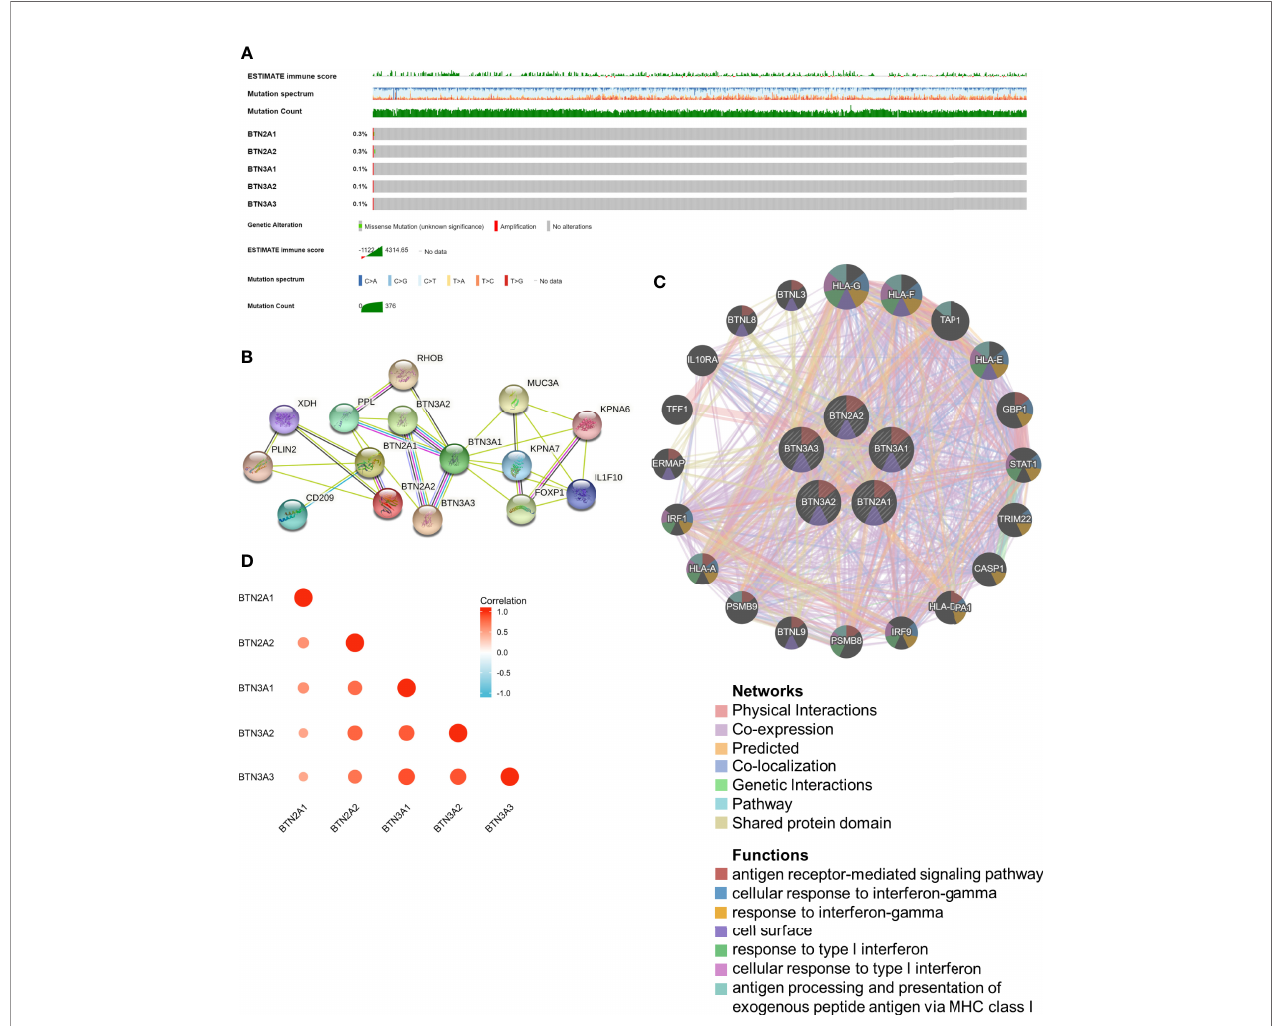
FIGURE 2 | Genomic alterations of BTN2/3 subfamily members and gene – gene and protein – protein interaction networks of genes of the TBC1D3 family. (A) The OncoPrint schematic provides an overview of genomic alterations of the BTN2/3 subfamilies in TCGA-GBMLGG merge cohort. (B) A network diagram of interactions between proteins encoded by genes of the BTN2/3 subfamilies, drawn using STRING. (C) The gene network associated with the BTN2/3 subfamilies, drawn by using GeneMANIA. (D) Correlation analysis of BTN2/3 subfamily members. TCGA-GBMLGG, The Cancer Genome Atlas – glioblastoma and low-grade